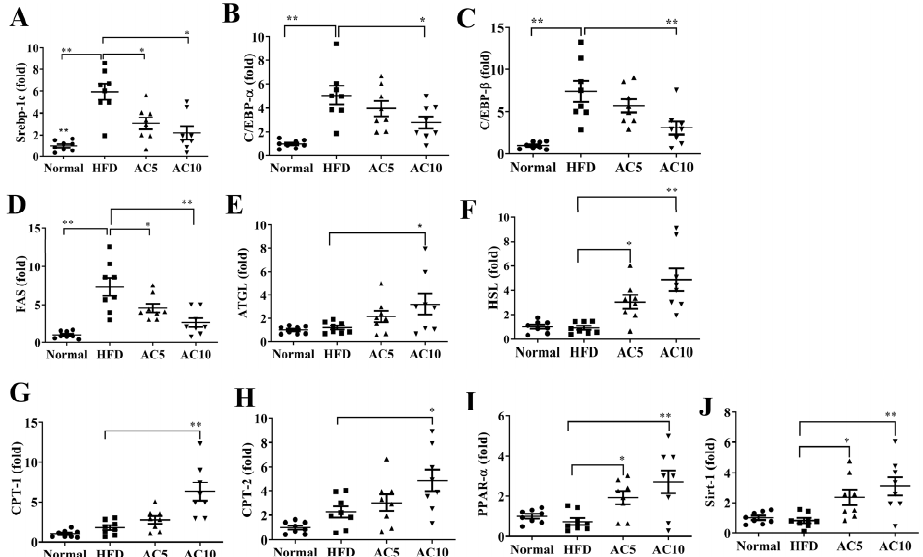
Figure 4. Acacetin (AC) modulated gene expression in liver tissue. Real-time RT-PCR detected the gene expression of ( A ) Srebp-1C, ( B ) C/EBP α , ( C ) C/EBP β , ( D ) FAS, ( E ) ATGL, ( F ) HSL, ( G ) CPT-1, ( H ) CPT-2, ( I ) PPAR- α , and ( J ) Sirt-1. The fold values were measured relative to β -actin expression. Int. J. Mol. Sci. 2022 , 23 , x FOR PEER REVIEW Values are presented as mean ± SEM. * p < 0.05, ** p < 0.01 compared to obese mice.